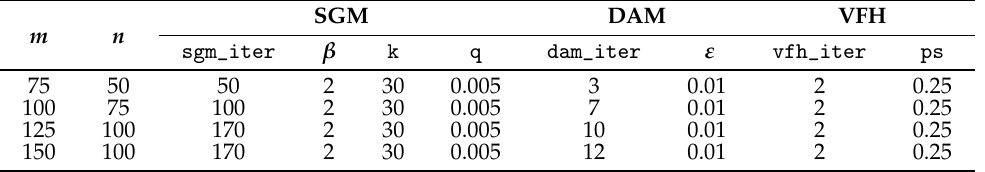
Table 1. Parameter settings of the ADA algorithm for the indicated method. Source: the authors.